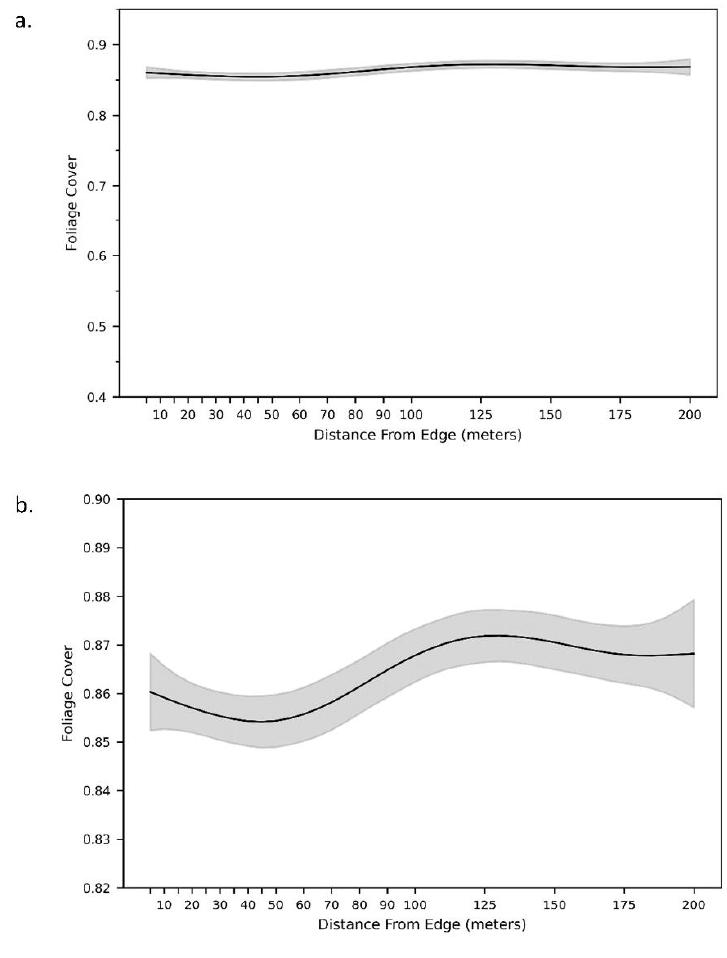
Figure 7. Results of the GAM model based on the modified LAB2 estimates of foliage cover (FC). Plots show the trend in FC with distance from edge for the same model but with different Y-axis scales. The Y-axis scale for ( a ) matches the scale of the axis in Figure 4. The Y-axis in plot ( b ) is narrowed to visualize the trend better. The shaded area represents the 95% confidence interval. FC is shown as decimal percentages between 0 and 1 with 1 indicating 100% cover.